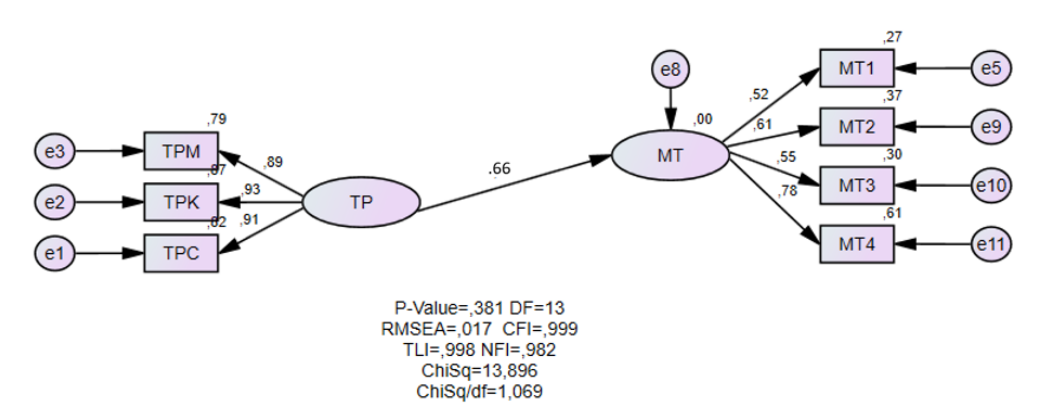
Figure 4  The association between perception and stakeholder